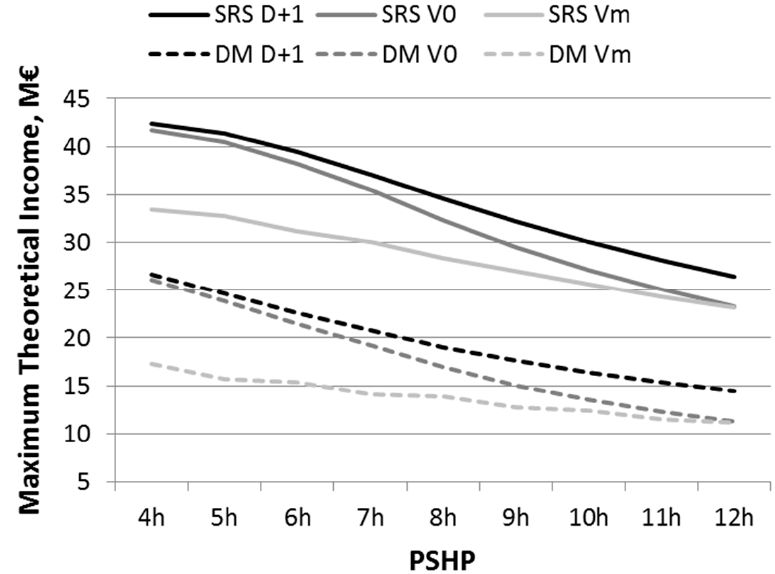
Figure 3. Annual maximum theoretical income, in millions of € , of each PSHP participating in the DM and the SRS (solid lines) and only in the DM (dashed lines).